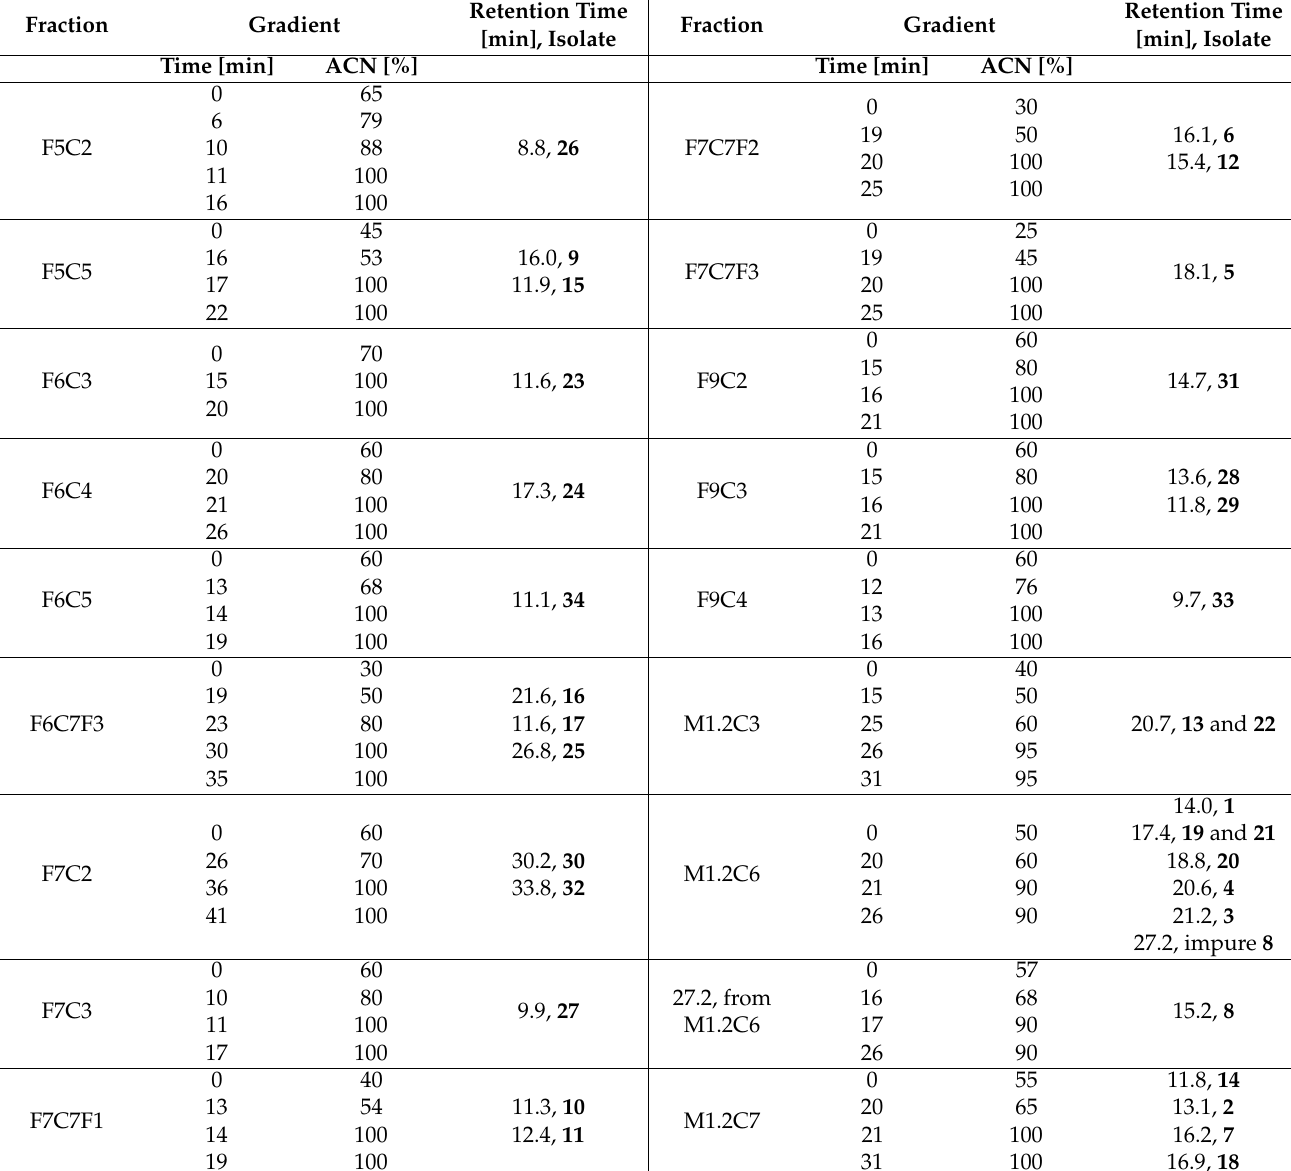
Table 5. The gradients consisting of water and ACN used to separate the respective fractions and the retention times of the isolates. A biphenyl column as specified in the text was used for the separation of all fractions except M1.2C6 and M1.2C7, for which the Nucleodur C18 was